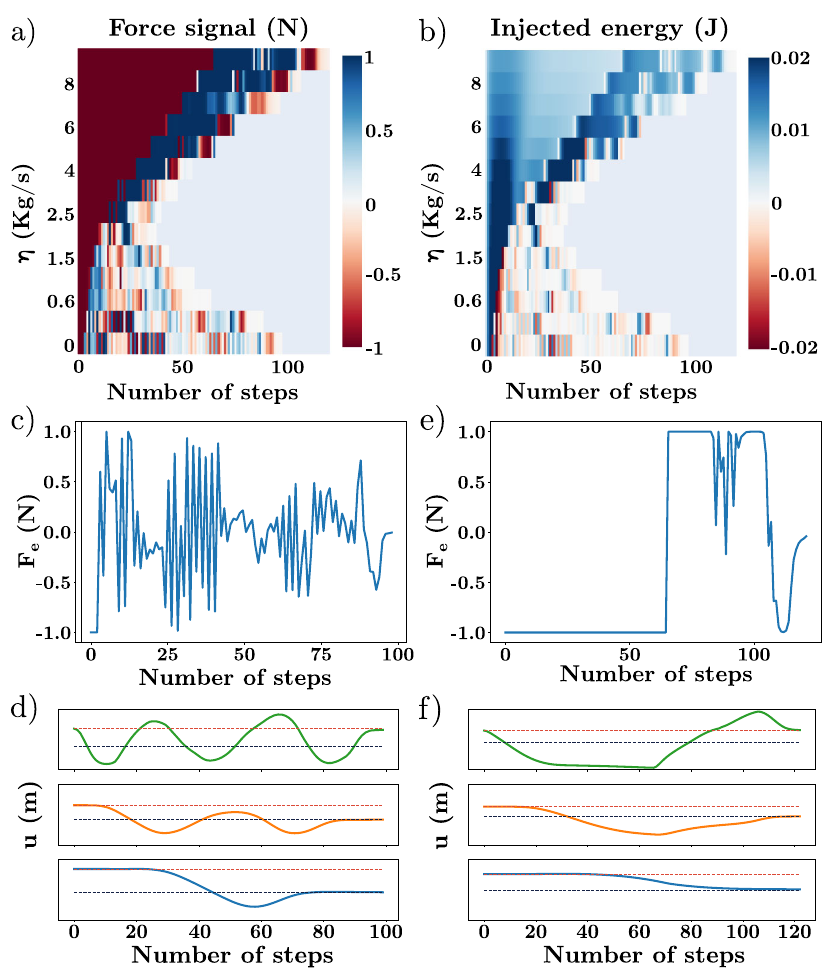
Fig. 3 Analysis of the transition protocol proposed by the reinforcement learning agent. The fi gure corresponds to the transition 111 → 001 for different values of the viscous coef fi cient. a Force signal and b injected energy during the transition. The injected energy is computed by multiplying the chain ʼ s elongation with the value of the external force. c Force signal and d deformation of each bi-stable spring during the transition for η = 0 kg s − 1 (low-viscosity regime). The colors blue, orange, and green correspond to the deformation of the fi rst, second, and third spring, respectively. The subplots for the deformations all have the same height with edge values [ − 0.07, 0.19] meter. The dashed lines represent the stable equilibria δ (0) (black) and δ (1) (red). e Force signal and f deformation of each bi-stable spring during the transition for η = 9 kg s − 1 (high-viscosity regime). The subplots for the deformations all have the same height with edge values [ − 0.14, 0.24]